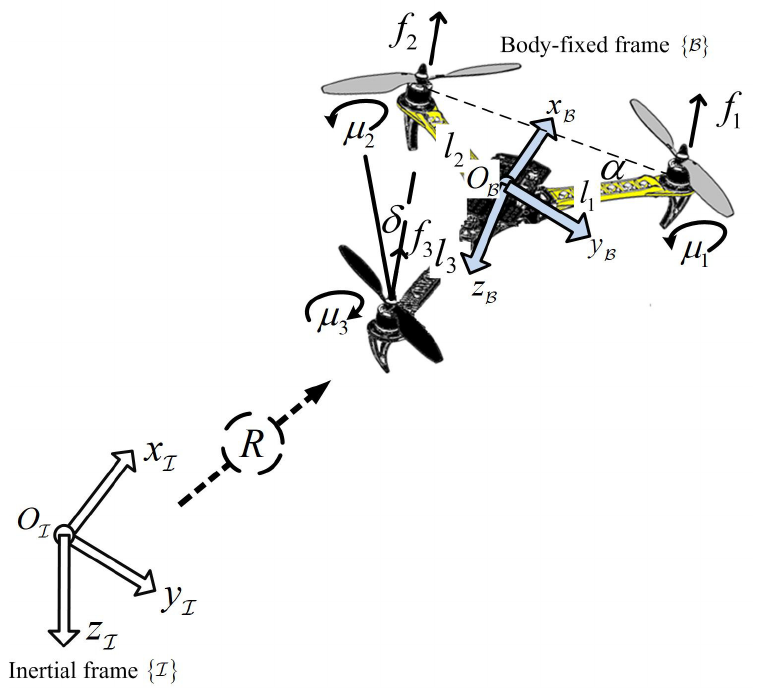
Figure 1. Schematic of tri-rotor